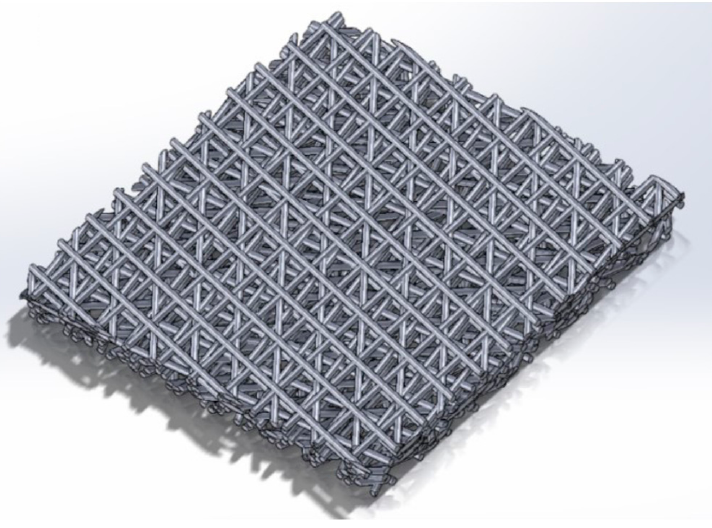
Figure 3. CAD sample constructed using Solidworks for D5 sample.